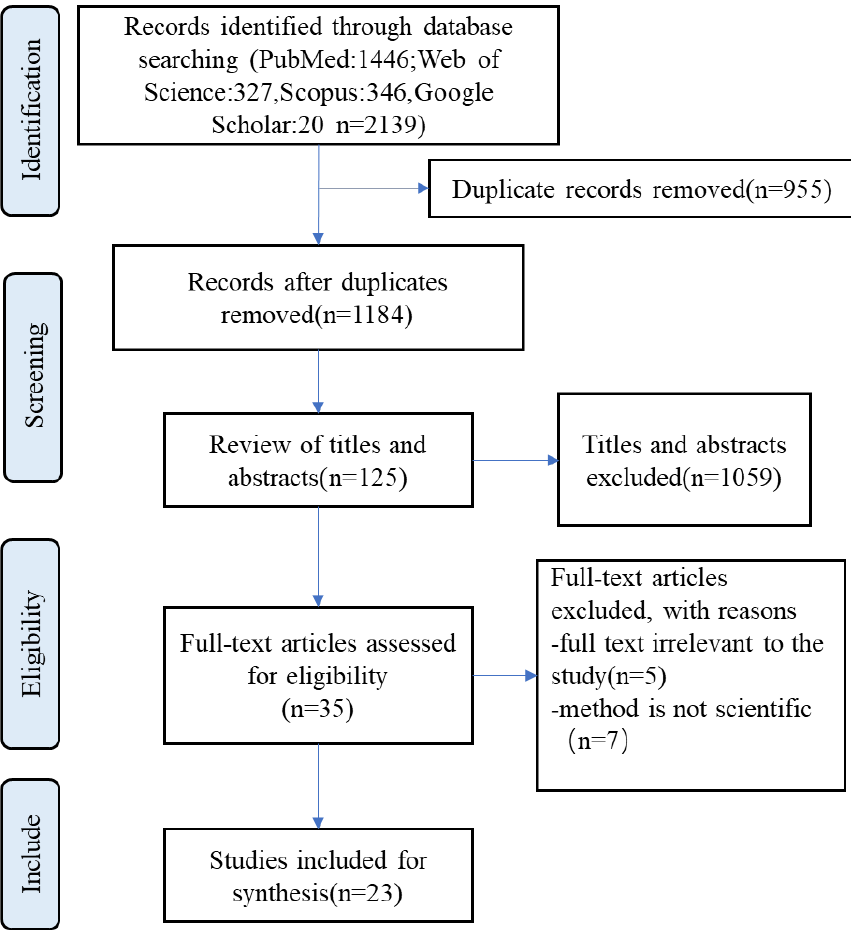
Figure 1. Selection process flow diagram.